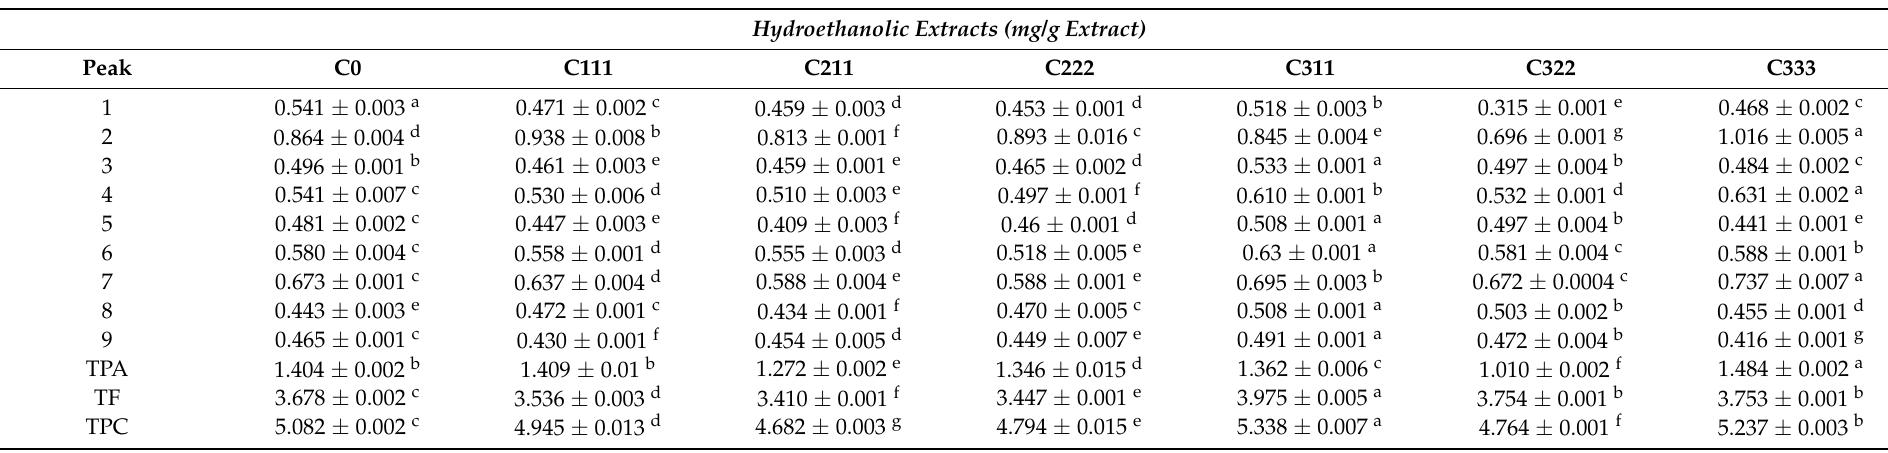
Table 6. Quantification (mg/g extract) of the phenolic compounds found in the hydroethanolic and aqueous extracts of C. spinosum samples (mean ±